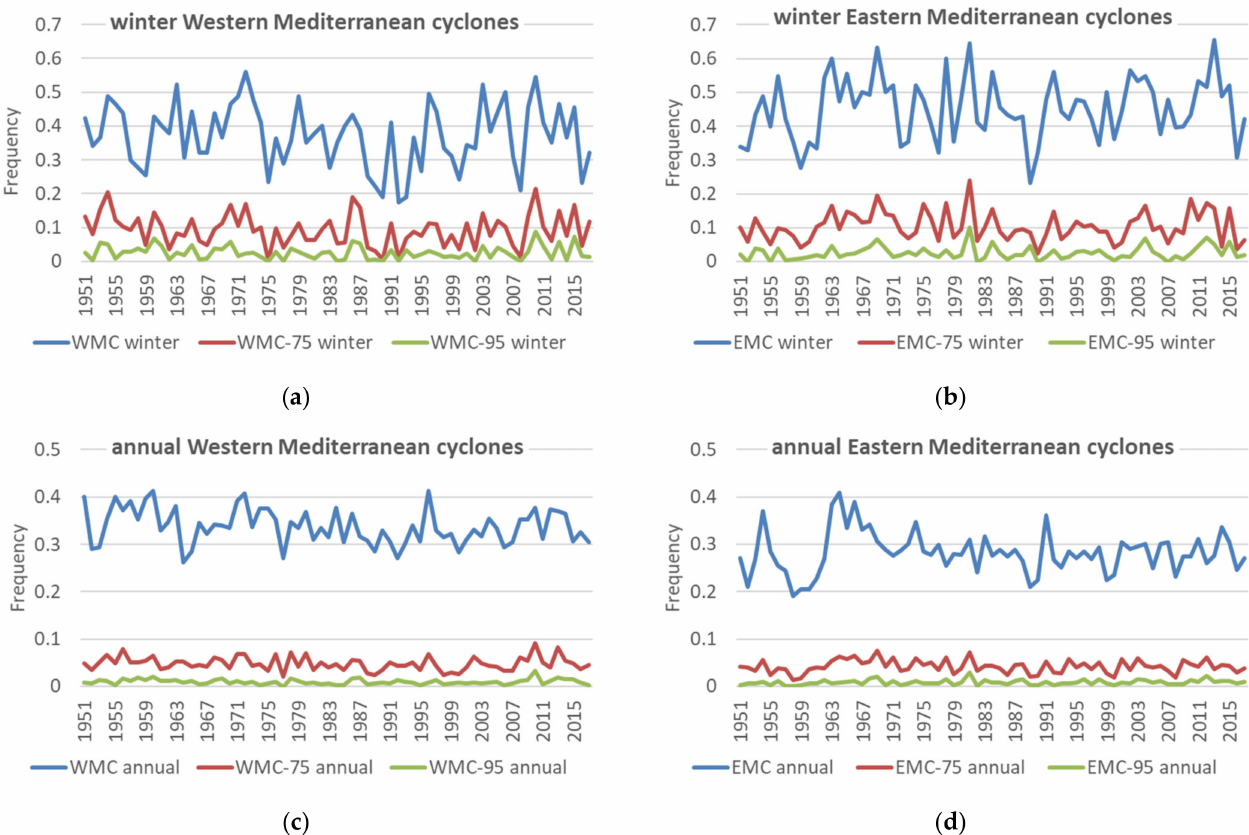
Figure 4. Time plots of the frequency of total number/intense/extreme cyclones over the Western and Eastern Mediterranean (WMC/WMC-75/WMC-95 and EMC/EMC-75/EMC-95, respectively): ( a , b ) winter averages; ( c , d ) annual